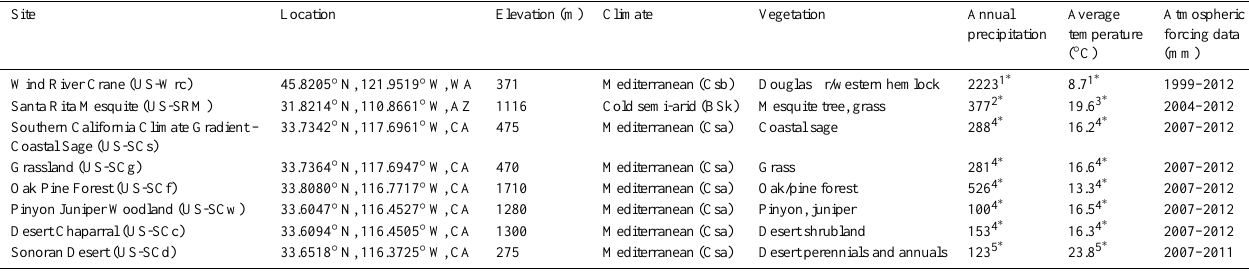
Table 1. Study site information.